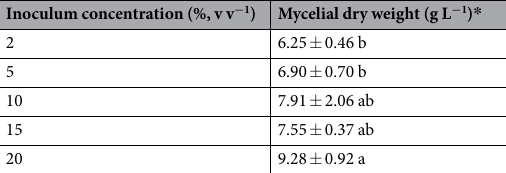
Table 2. Effect of inoculum concentration on the mycelial growth of Isaria farinosa . * Mean ± SE. Values followed by the same letters within a column do not differ significantly (ANOVA, P =